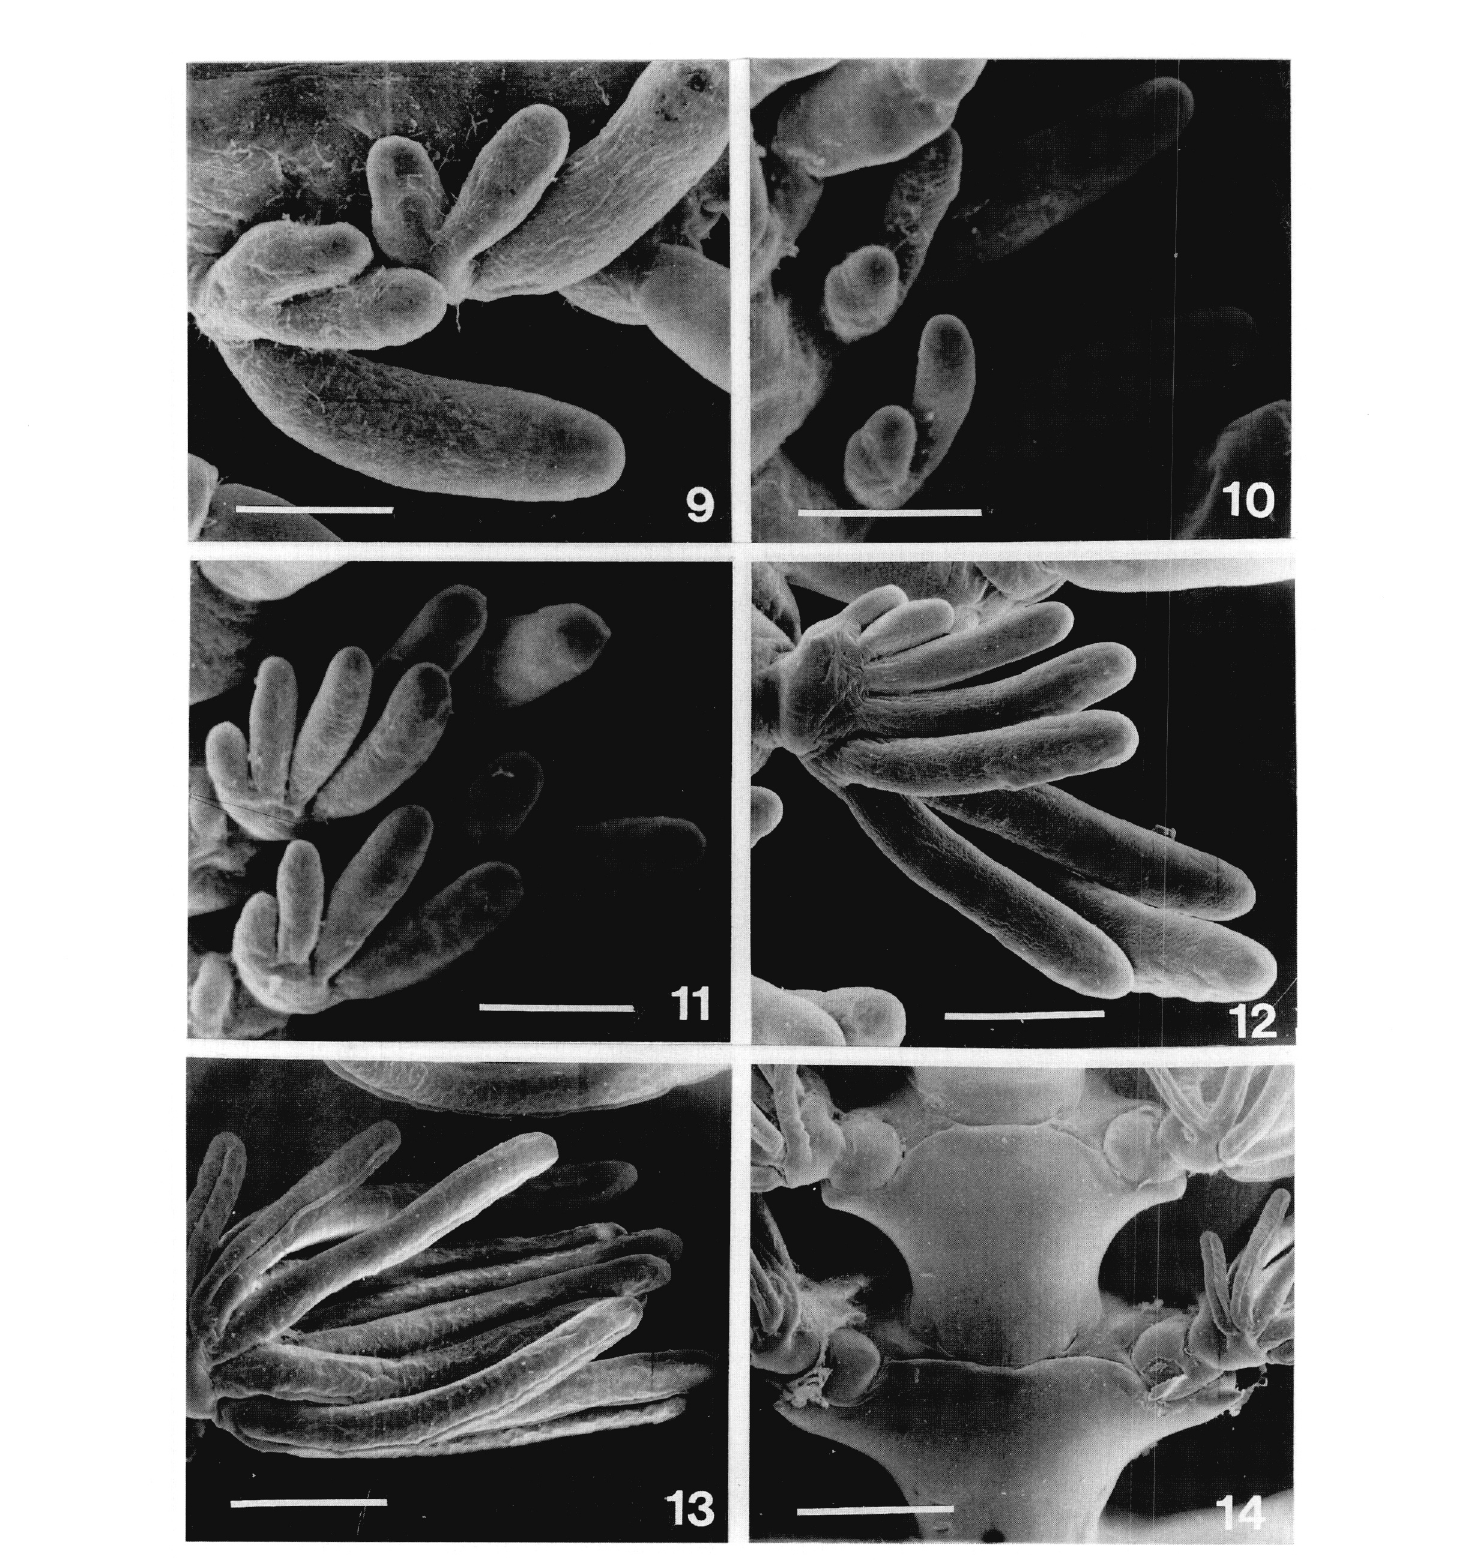
Fig. 9. - Neocyamus physeteris (Pouchet, 1888). Stade trois branchies (échelle : 150 μ m). Fig. 10. - Neocyamus physeteris (Pouchet, 1888). Stade trois branchies. On peut remarquer que la branchie interne est en cours de dédou­ blement (échelle : 200 μm). Fig 11. - Neocyamus physeteris (Pouchet. 1888). Stade six branchies (échelle : 200 μm). Fig 12. - Neocyamus physeteris (Pouchet, 1888). Stade huit branchies (échelle : 200 μm). Fig. 13. - Neocyamus physeteris (Pouchet, 1888). Stade 11 branchies (échelle : 300 μm). Fig. 14. - Neocyamus physeteris (Pouchet, 1888). Vue ventrale de la région thoracique d’un mâle (échelle : 600 pm).